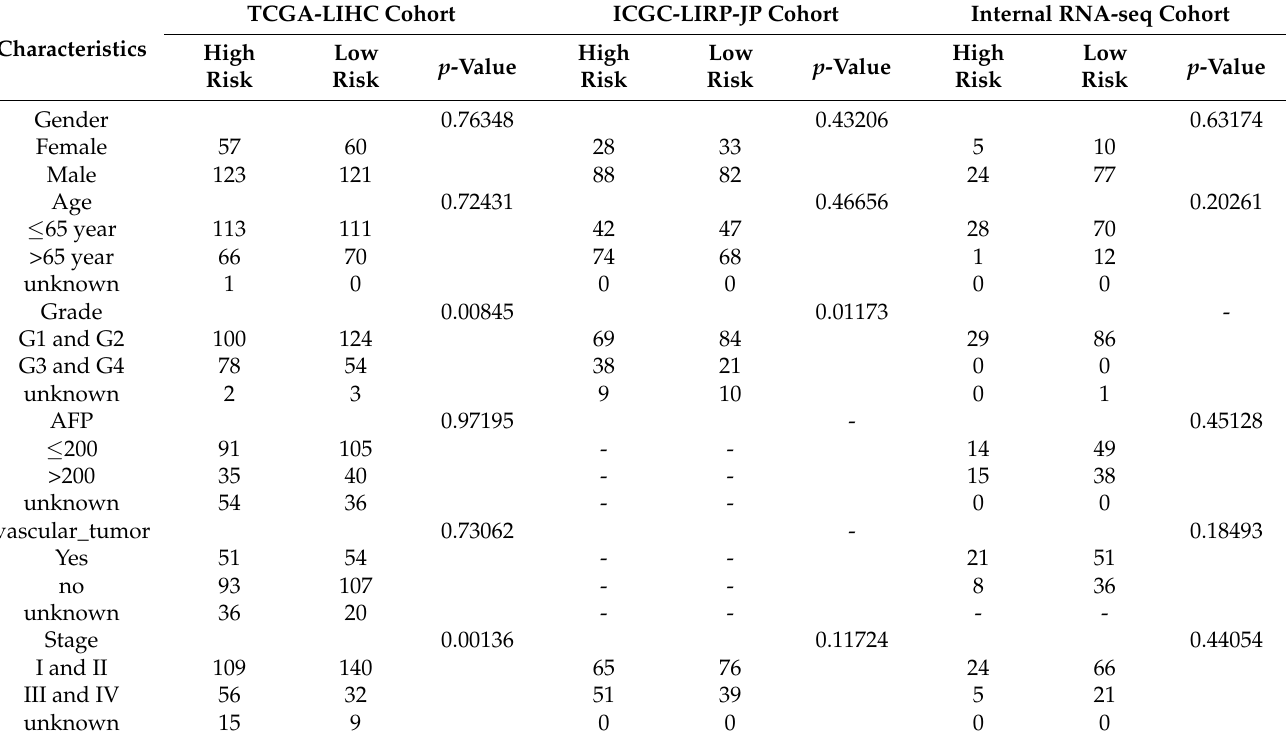
Figure 3. Four-gene signature model was constructed using the TCGA cohort data. ( A ) Risk curves show the distribution of sample risk values. ( B ) PCA analysis of high- and low-risk groups. ( C ) t-SNE analysis of two groups was performed. ( D ) Survival status vs. time. The graph shows that with the increase in risk, the number of deaths increased. ( E ) K – M curve for the two groups. ( F ) Time-dependent ROC curve of risk score prognostic performance. Table 3. Clinical information of the patients in high- and low-risk groups in the three